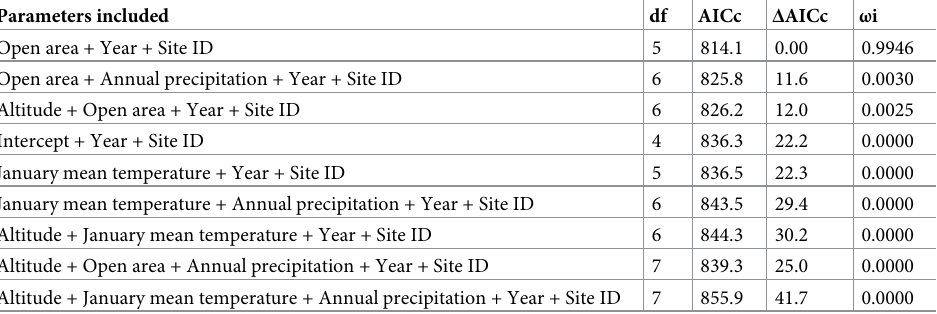
Table 2. Model selection (based on the AICc criteria) of considered multiple regression models aiming to investi- gate the effect of forest cover, mean January temperature, annual precipitation, and altitude on δ 15 N values in bone collagen of red deer from different sampling sites in Europe.